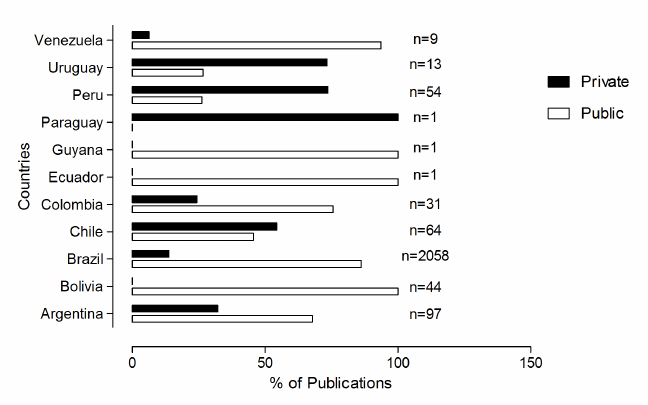
Figure 3. Percentage distribution of public versus private institutional predominance by country in the last 42 years of sports science